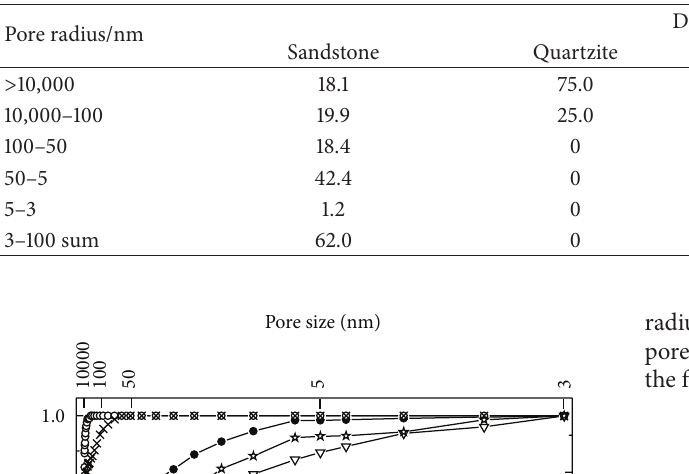
Table 3: Pore distribution ratios of different coarse aggregates.